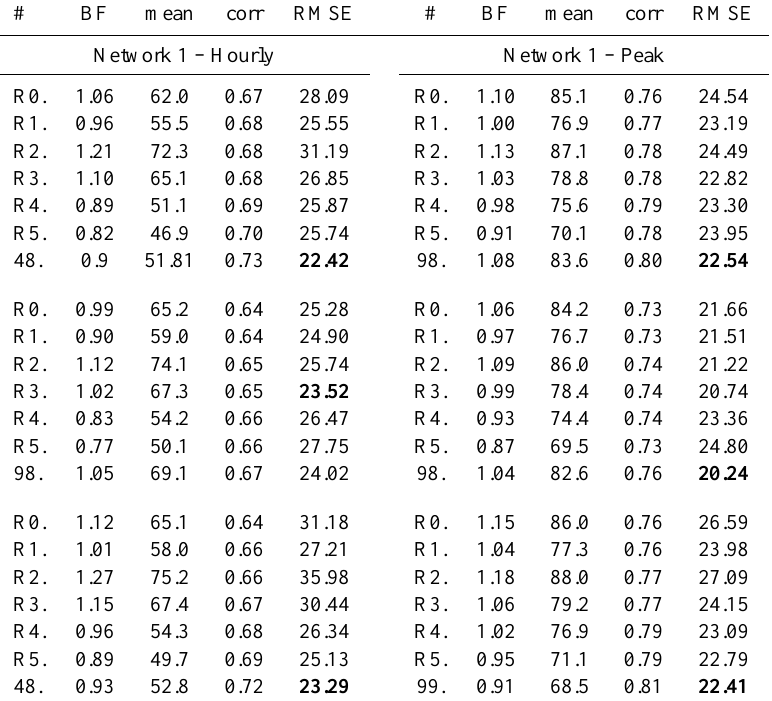
Table 5. Statistical measures for the 6 reference models and the best model from the 101-member ensemble, for hourly ozone concentrations and hourly ozone peaks. R0–5 refer to the 6 reference models.